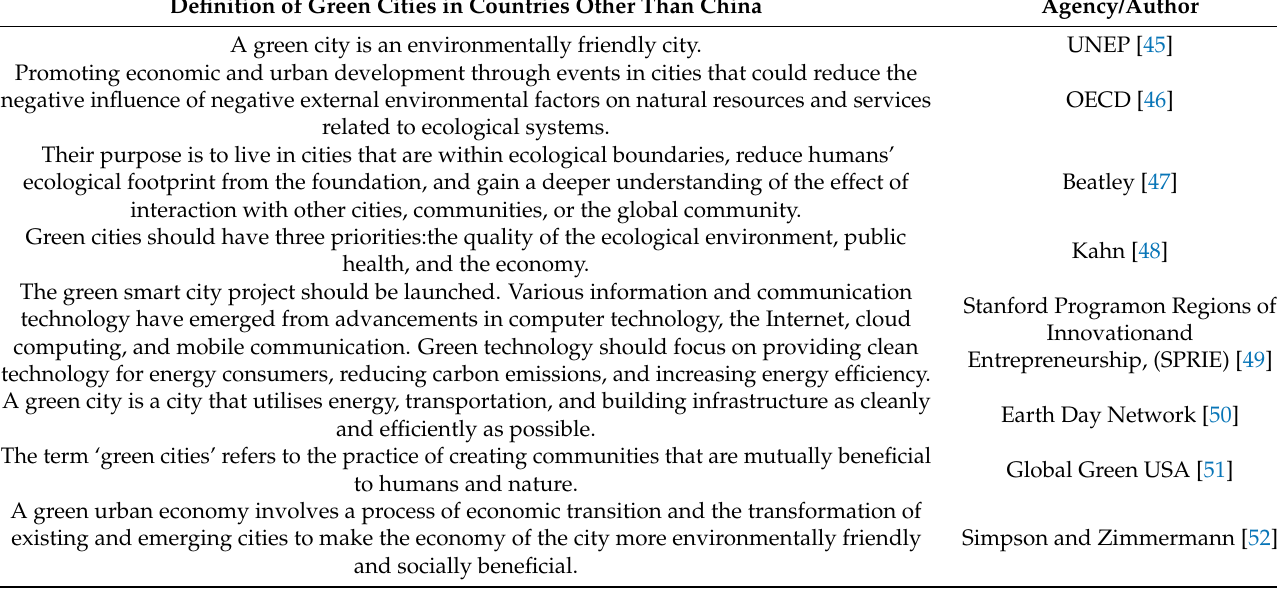
Table 1. Development of the concept of green cities in various